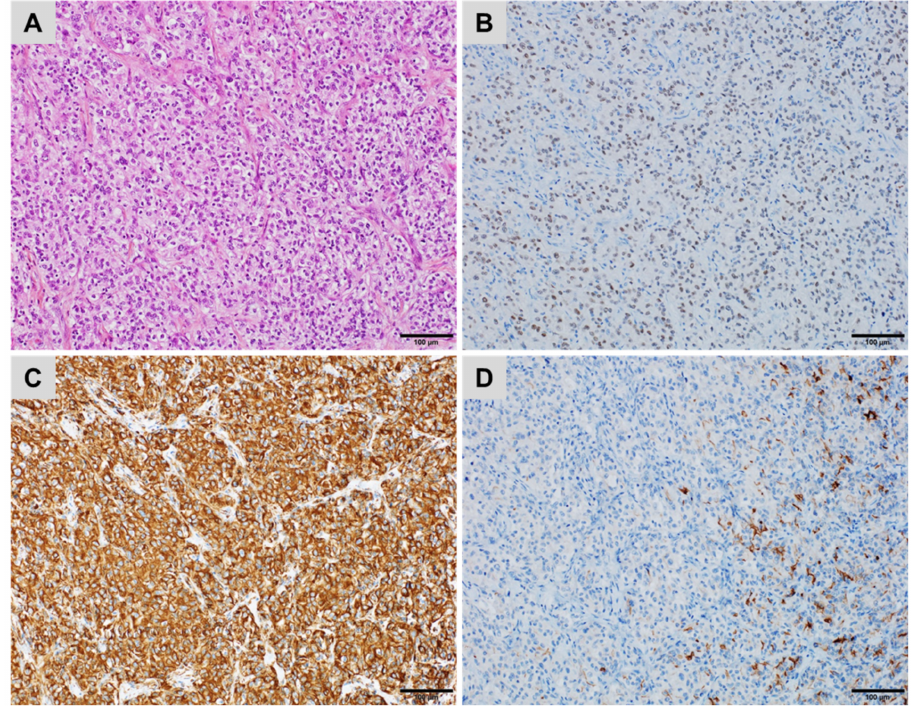
Figure 8. A metastatic renal cell carcinoma (( A ) haematoxylin, eosin and safran) showing ( B ) diffuse nuclear staining for PAX8, ( C ) diffuse, strong cytoplasmic staining for Vimentin but ( D ) only a few tumour cells stained for CD10 (( B – D )